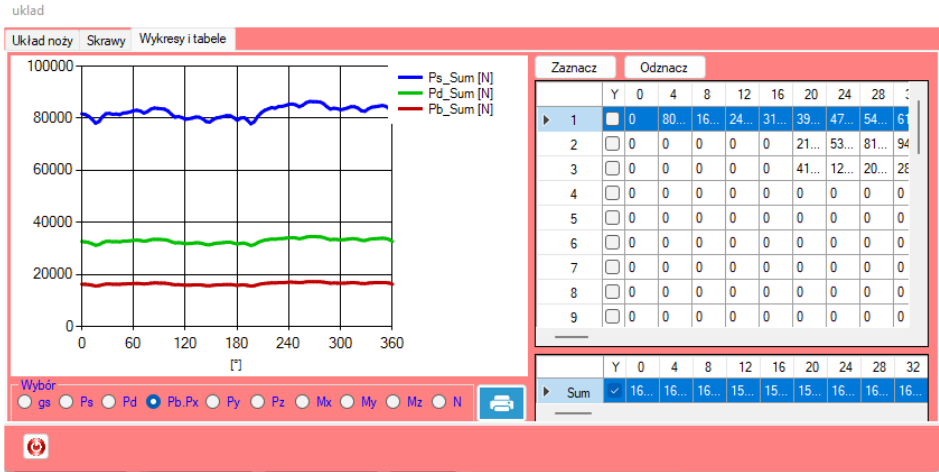
Figure 8. Movement trajectory of the manipulator tip’s movement for the minimal extension of the actuators.